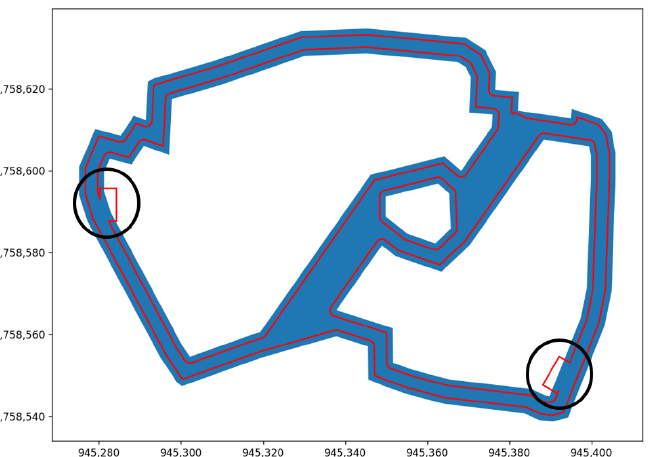
Figure 12. Headland travel space (blue), and the safety buffer (red line), and A* starting point cutouts (circles in black).